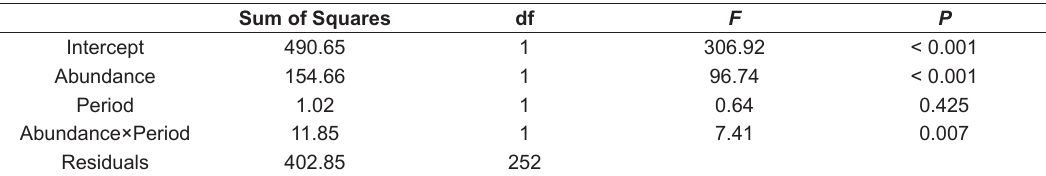
Table 1. Results of the analysis of covariance (ANCOVA) evaluating the relationship between zooplankton occupancy in the Araguaia River floodplain and the explanatory variables (logarithm of abundance and hydrological period). Sum of Squares df